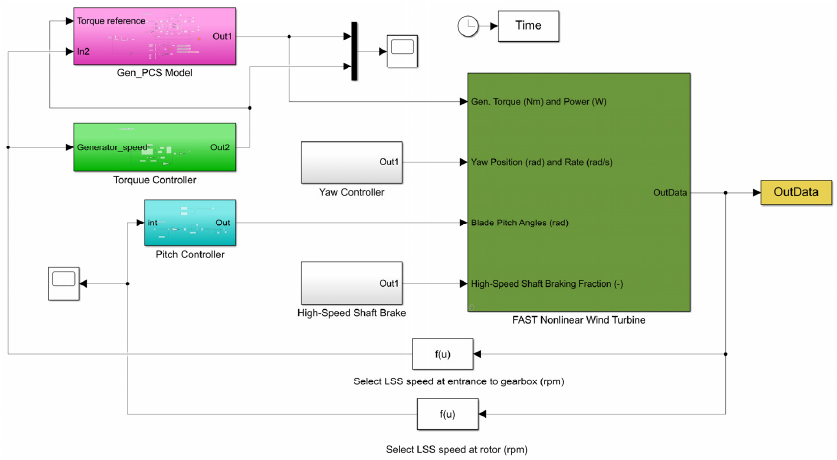
Figure 6. Matlab/Simulink based FAST